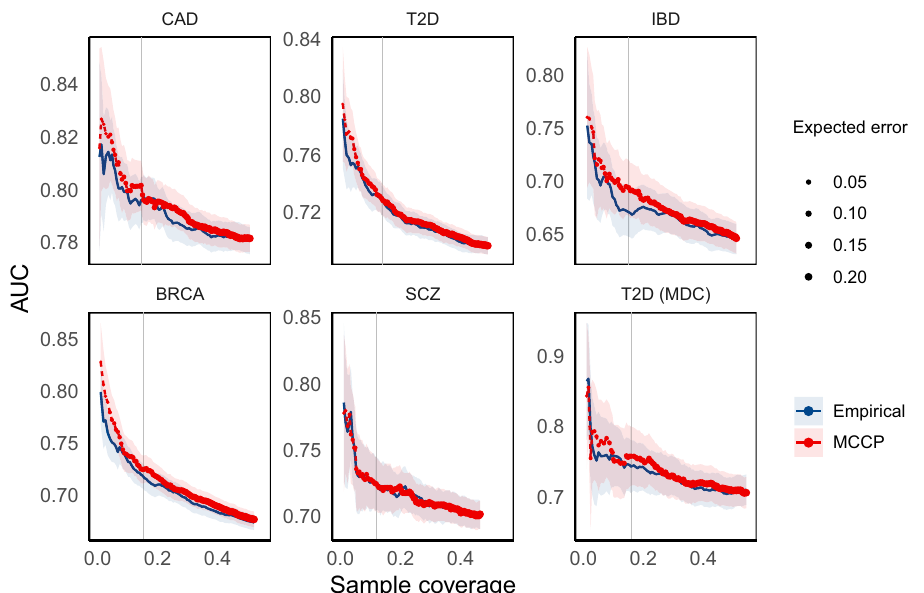
Fig. 3 Comparison of the performance of MCCP and the empirical method on complex disease risk prediction using PRS as predictor. For MCCP, sample coverage ( x axis) indicates the proportion of samples predicted as cases or controls, whereas, for the empirical method, it indicates extreme PRS, e.g., top and bottom x% of PRS. AUCs are computed from multivariate logistic regressions adjusted for age, sex, and PC1 – 6 on these samples strati fi ed from MCCP and empirical method, respectively. The expected error rates for MCCP are indicated by the size of data points up to 0.20. Vertical lines correspond to an expected error of 0.05 from the MCCP. The solid lines and shades represent the median and 95% con fi dence intervals of AUCs. CAD coronary artery disease, T2D type 2 diabetes mellitus, IBD in fl ammatory bowel disease, BRCA breast cancer, SCZ schizophrenia, T2D (MDC) T2D data set from the MDC study at the baseline. Source data are provided as a Source Data fi le.